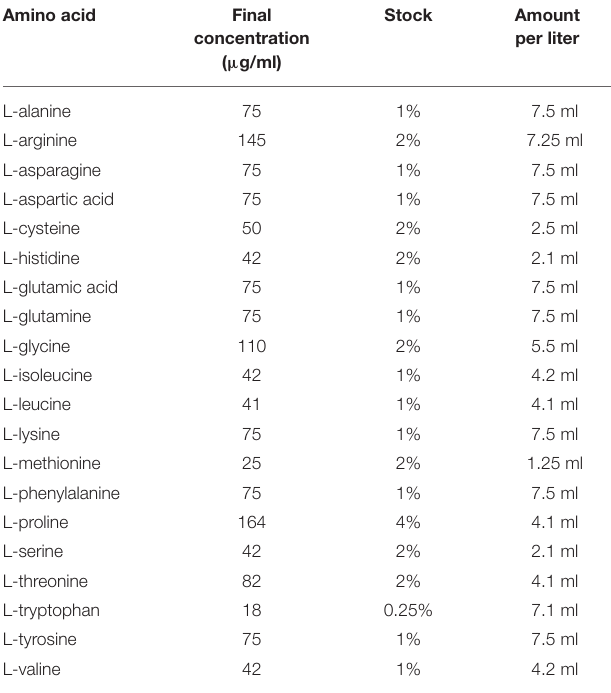
TABLE 1 | Levels (5 × concentration) of amino acids in M9 minimal medium. Amino acid Final